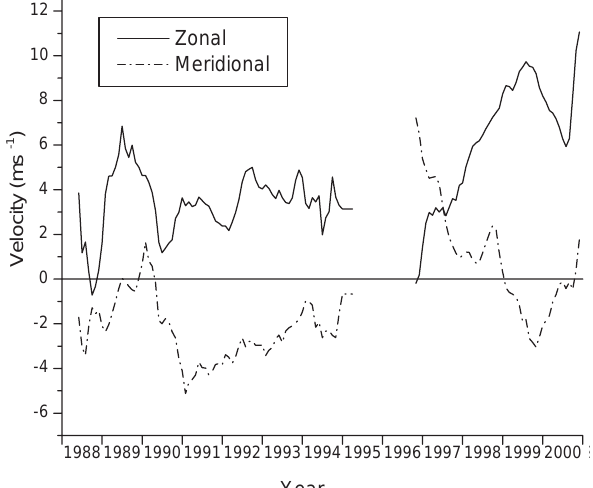
Fig. 10. 12-month running mean of zonal and meridional monthly- mean